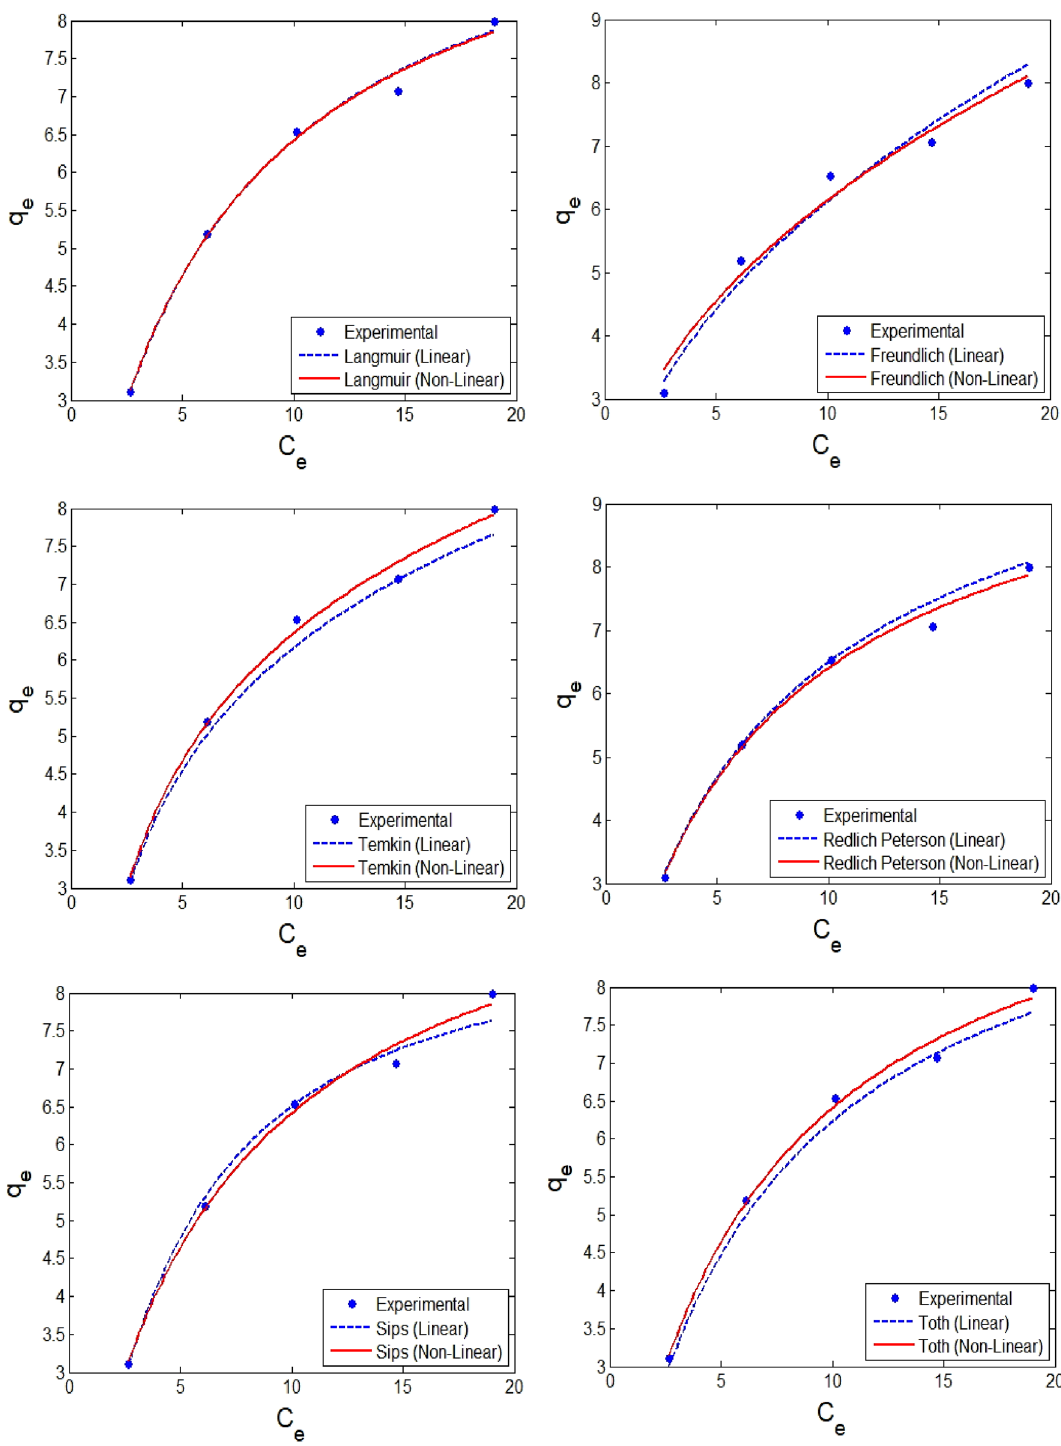
Figure 8. Performance of parameters estimated by linear and non-linear approaches to fit isotherm models that interpret the adsorption of diazinon by pumice (pumice dosage = 1 g/L, and contact time = 30 min, and pH =